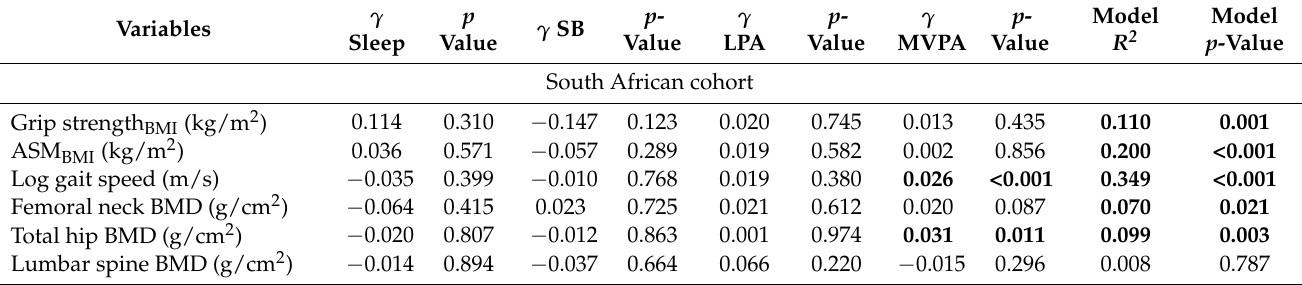
Table 3. Compositional linear regression for the associations between movement behaviors and musculoskeletal outcomes.